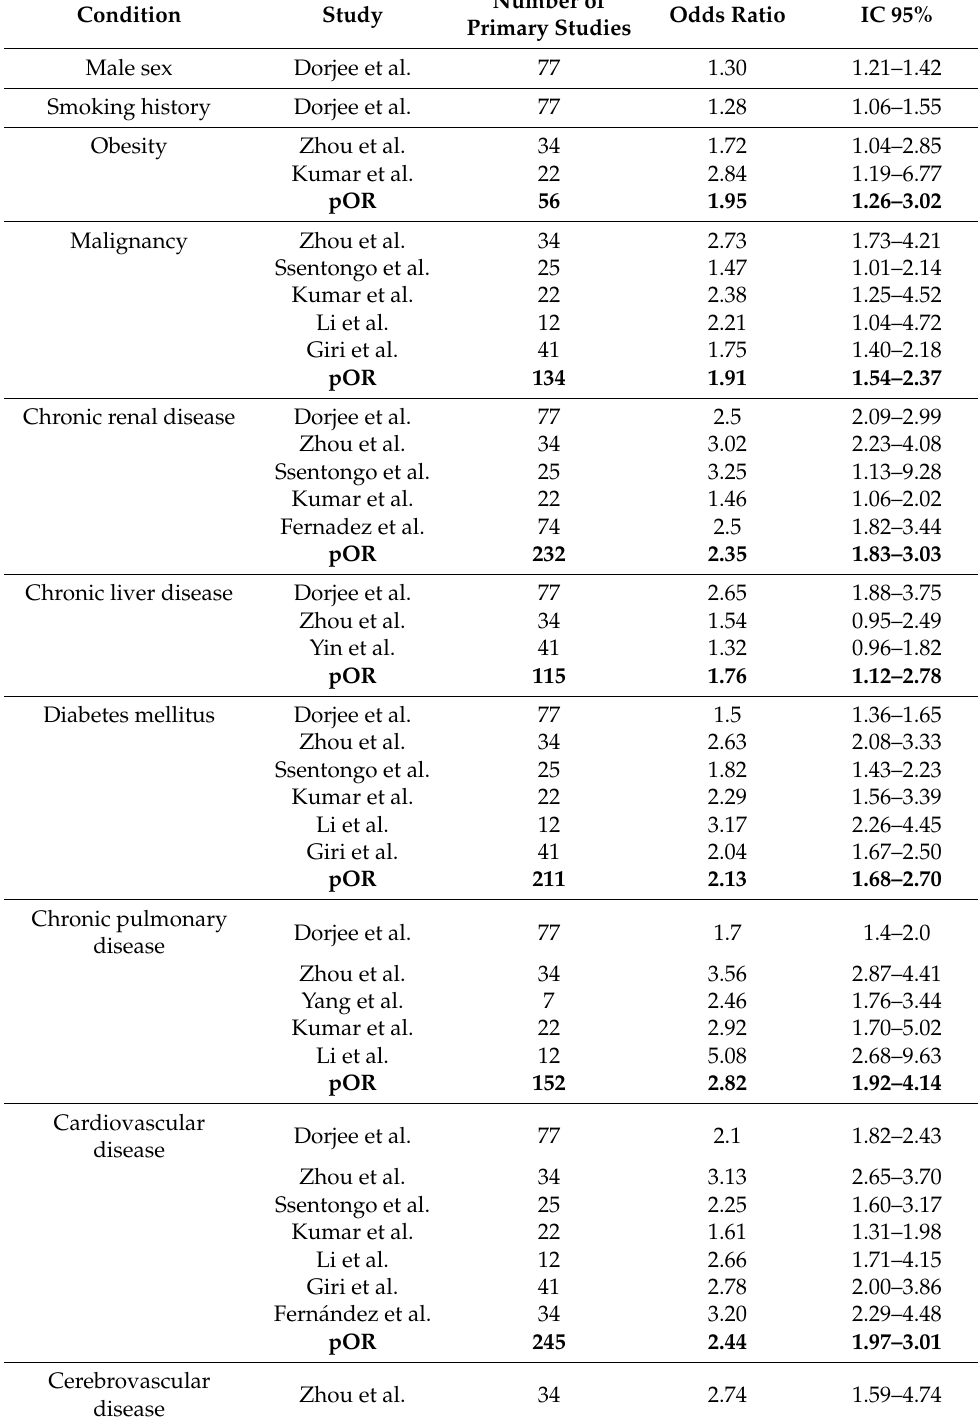
Table 3. Meta-analysis of the different patients’ characteristics and underlying conditions and the risk of development of severe/critical